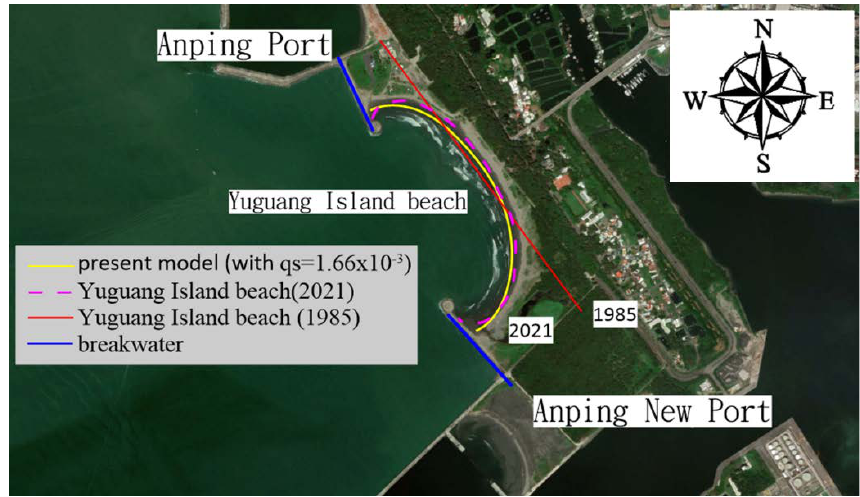
Figure 15. The profiles of shoreline in Yuguang Island Beach at 1985 and 2021.